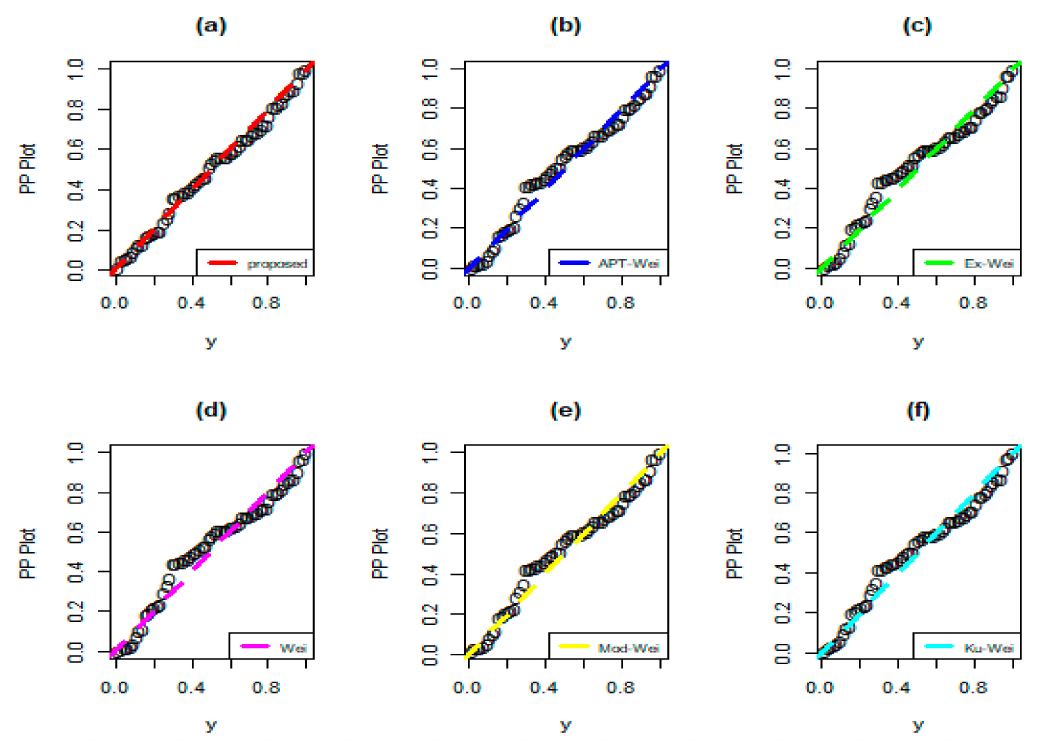
Figure 13. Probability–probability (PP) plots of ( a ) NMEPA-Wei, ( b ) APT-Wei, ( c ) Ex-Wei, ( d ) Wei, ( e ) Mod-Wei, and ( f ) Ku-Wei for Data